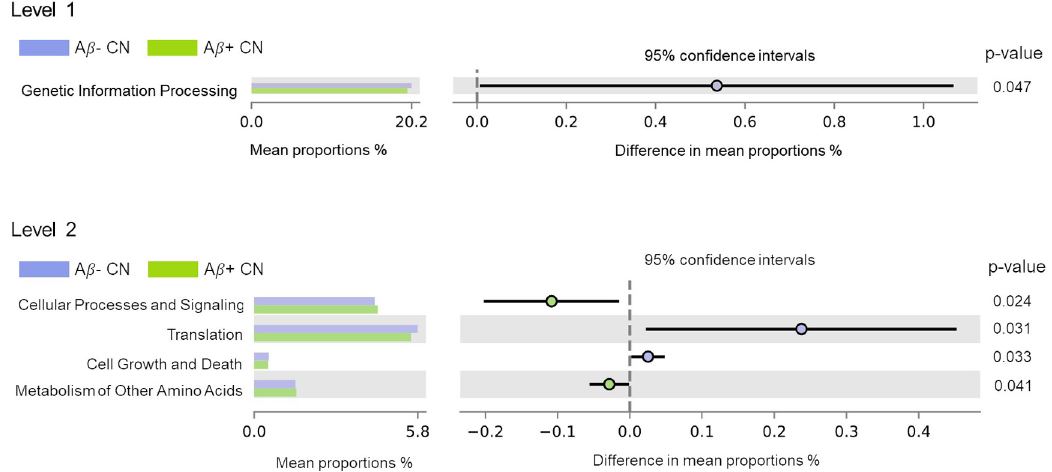
Fig 3. Relative differences in predicted gene contents in microbiome between A β − CN participants and A β + CN participants. Abbreviations. A β + CN: cognitively normal participants with amyloid retention A β − CN: cognitively normal participants without amyloid